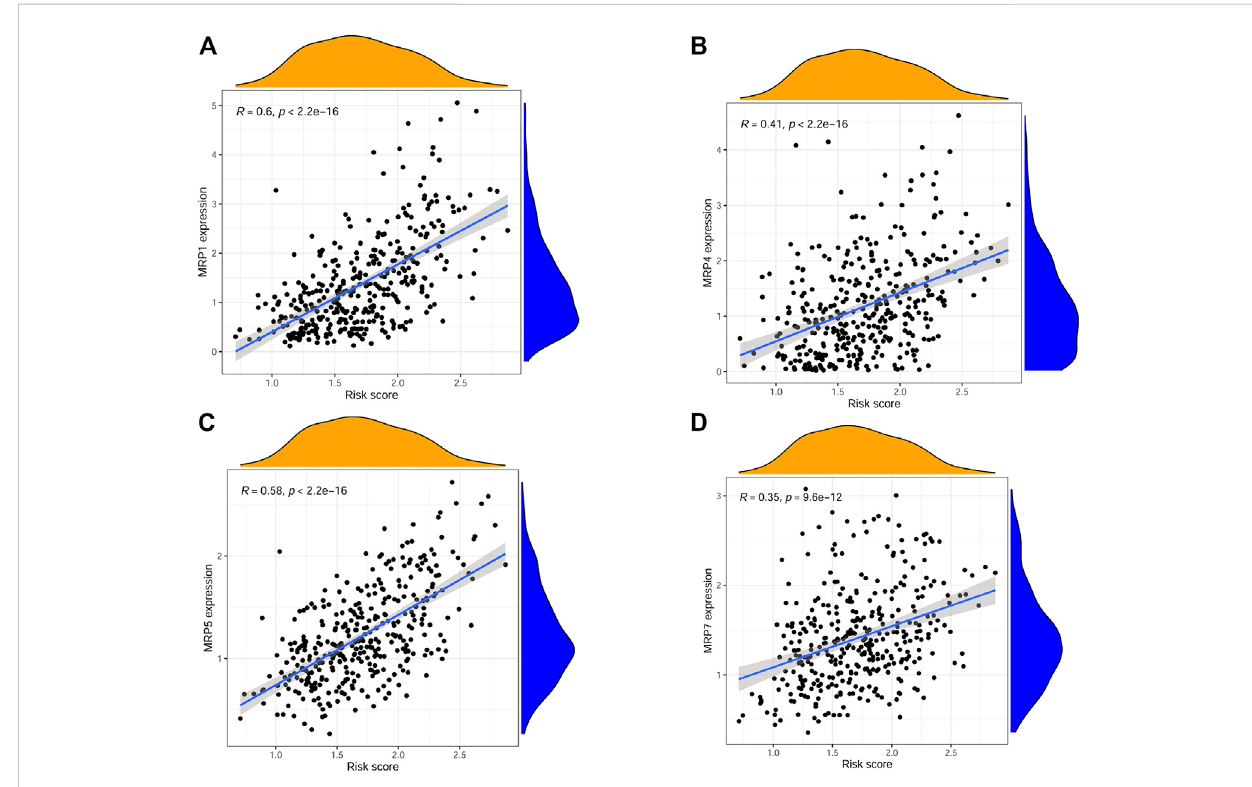
FIGURE 8 Scatter plots showing the relationship between risk score and MRP1, MRP4, MRP5, MRP7. (A – D)